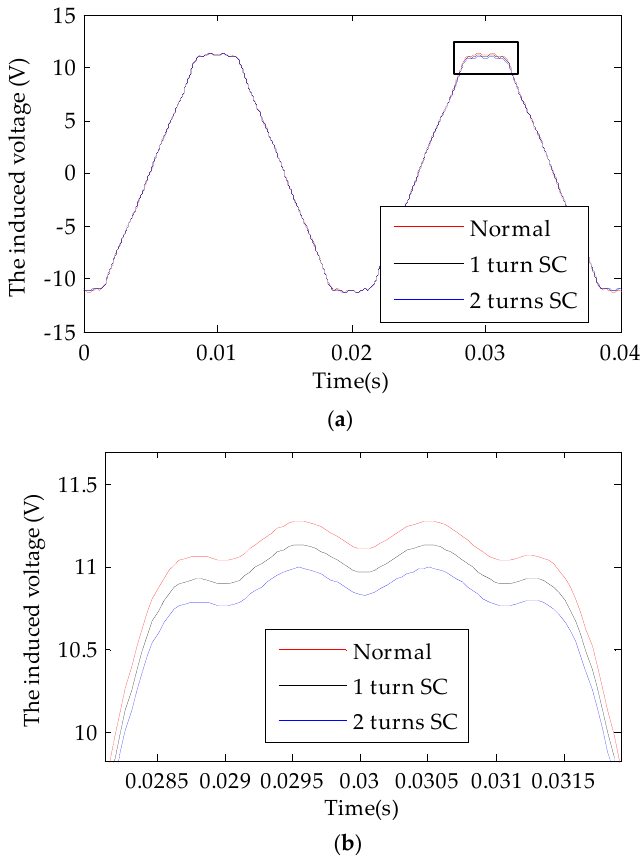
Figure 6. Induced voltage curve for the No. 1 detection coil with different short circuit degrees in slot #3 under no-load conditions: ( a ) Global map; ( b ) Local map. Where, SC is the abbreviation of Short Circuit.